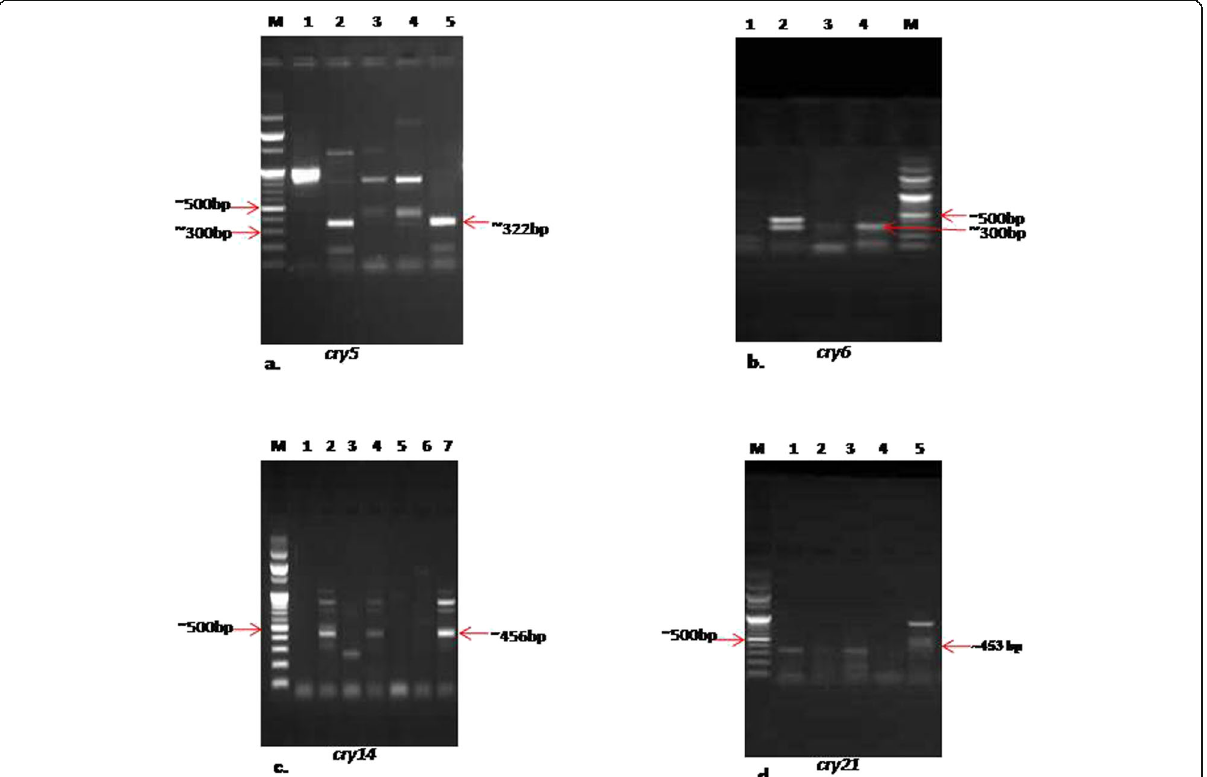
Fig. 1 PCR screening of nematicidal genes in native Bacillus thuringiensis isolates. a cry 5at 322 bp (M, marker; lanes 1 to 5, native Bt isolates), b cry 6 at 302 bp (M, marker; lanes 1 to 4, native Bt isolates), c cry 14 at 456 bp (M, marker; lanes 1 to 7, native Bt isolates), d cry 21 at 453 bp (M, marker; lanes 1 to 5, native Bt isolates)